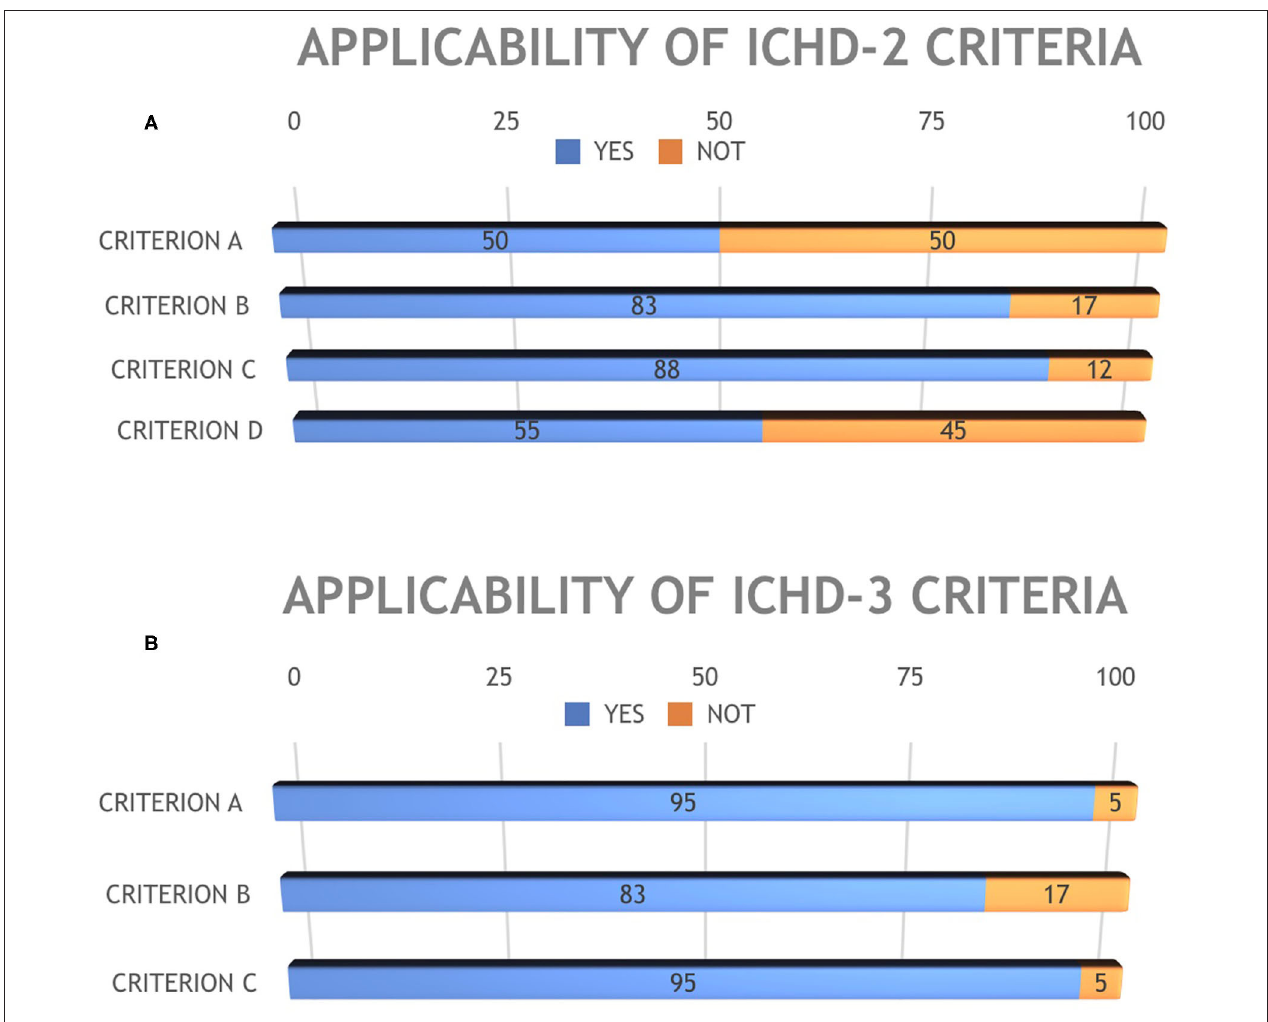
FIGURE 3 | Applicability of ICHD-2 (A) and ICHD-3 (B) diagnostic criteria for MOH.